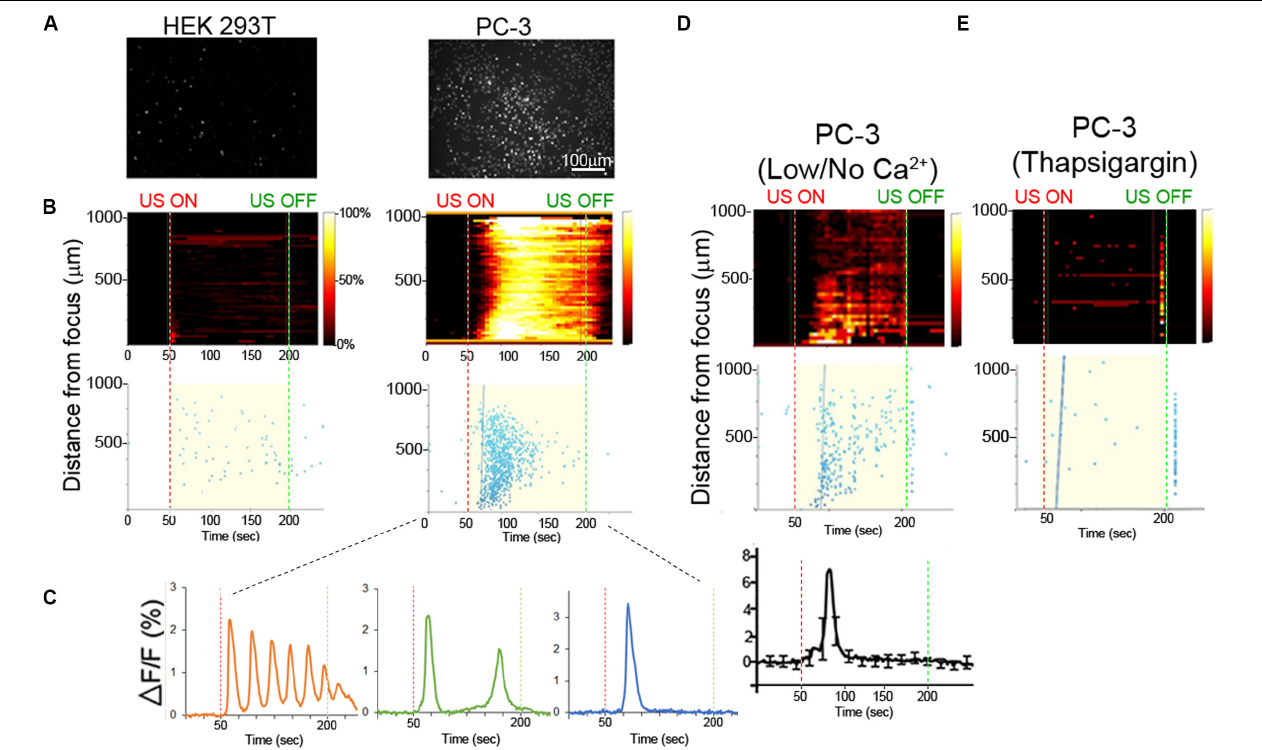
FIGURE 2 | Ca 2 + dynamics in invasive and non-invasive FUS stimulated cancer cells. (A) Background-subtracted fluorescence images show strong Ca 2 + signaling in invasive PC-3 (right) but not non-invasive HEK (left) cells. (B) Top, 2-D histograms showing the percentage of responding cells over time. Vertical red and green dotted lines indicate FUS stimulus onset (50 s) and offset (200 s) times, respectively. Bottom, scatter plots showing the time of the first response in individual cells following stimulus. (C) Typical Ca 2 + responses in invasive PC-3 cells exhibit either an oscillating (left), double (center) or single (right) spike pattern. (D) Ca 2 + responses are present in PC-3 cells in external no or 20 µ M (low) Ca 2 + concentration. (E) Thapsigargin (TG) treatment in the normal external Ca 2 + concentration (2 mM) drastically reduces the Ca 2 + response.